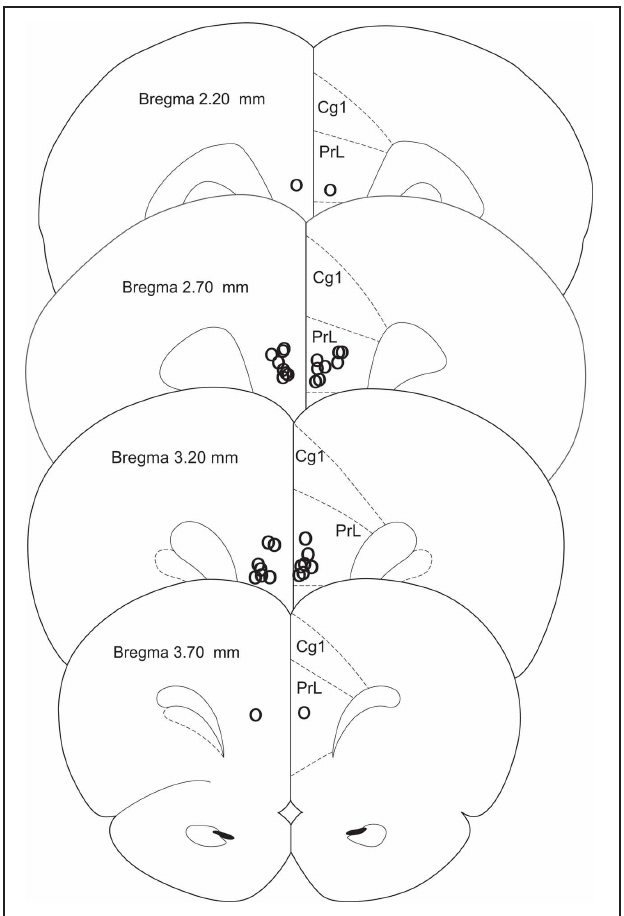
FIGURE 2 | Histology. Cannula placements in the present experiment. Only rats with injections in the prelimbic cortex were used in the experiment (CTRL n = 6, FEAR n =